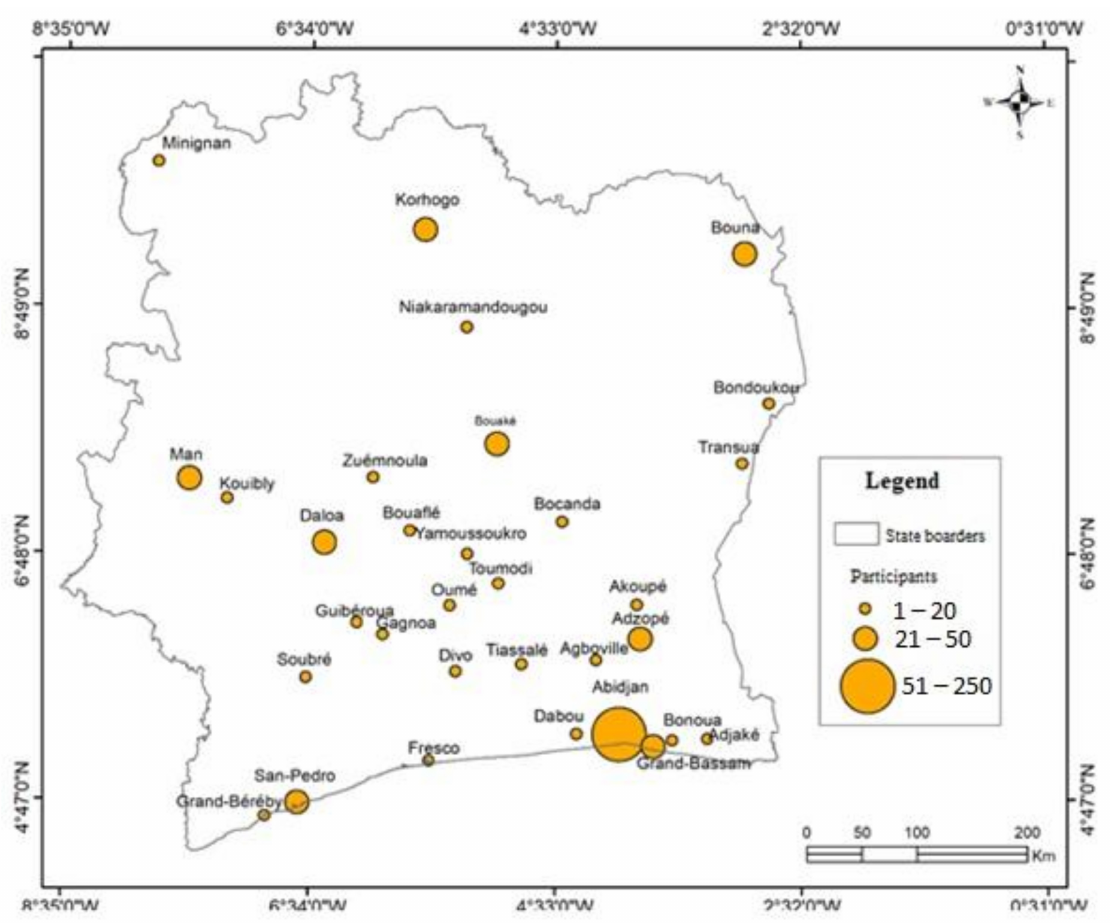
Figure 1. Study localities and number of participants allocated. The study was conducted from 26 April to 16 May 2020 in C ô te